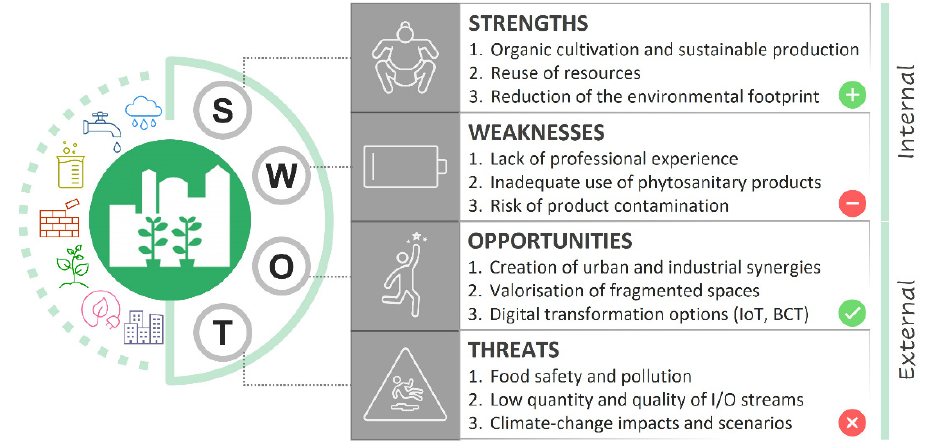
Figure 5. Strengths, weaknesses, opportunities and threats of nature-based agricultural solutions addressing the fifth urban circularity challenge to achieve circularity in cities.